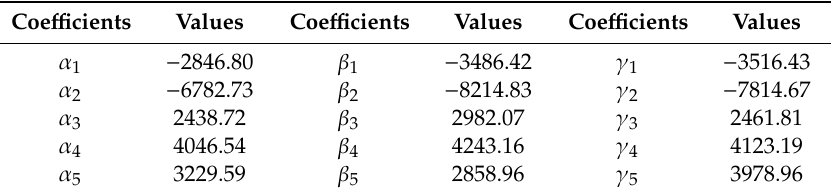
Table 11. Calculation-derived values of weight coe ffi